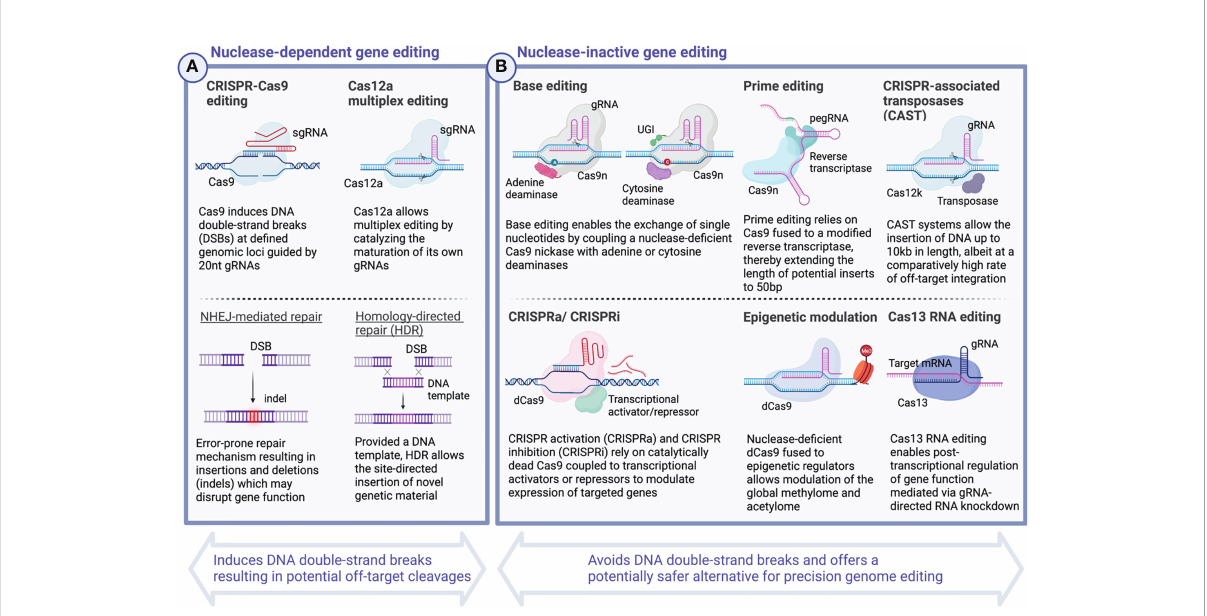
FIGURE 3 CRISPR - A versatile toolkit for the targeted deletion, rewriting and insertion of novel genetic information. Continuous iterations of technological innovation have considerably extended the scope and versatility of CRISPR-based gene editing strategies. Today, CRISPR genome editing encompasses a wide spectrum of diverse applications including the direct rewriting of genetic code, modulation of gene expression, and post- transcriptional RNA editing. While the most widely known CRISPR-Cas9 system and others rely on inducing DNA double-strand breaks (DSBs) and carry the potential risk of introducing deleterious effects arising from off-target cleavages (A) , other CRISPR-based editing tools, including base editing (105, 106) and prime editing (107), allow to rewrite the genetic code without the requirement for DNA double-strand cleavages and, hence, present a potentially safer alternative (B) . Over time, the possibilities to insert novel genetic material have expanded dramatically with the most recent advances including Twin prime editing (108) and CRISPR-associated transposase (CAST)-editing (109) now allowing large transgenic inserts in the range of up to 10-40 kb length. Besides editing the genetic code, powerful tools now exist which allow to tune transcriptional activation in a targeted manner. CRISPRa and CRISPRi rely on the site-directed delivery of transcriptional effector molecules to activate or repress gene expression (110 – 113). More profound epigenetic modulation can be achieved by tethering catalytically dead Cas9 to methyltransferases and acetyltransferases to alter the global methylome and edit histone modi fi cations (114 – 124). Created with